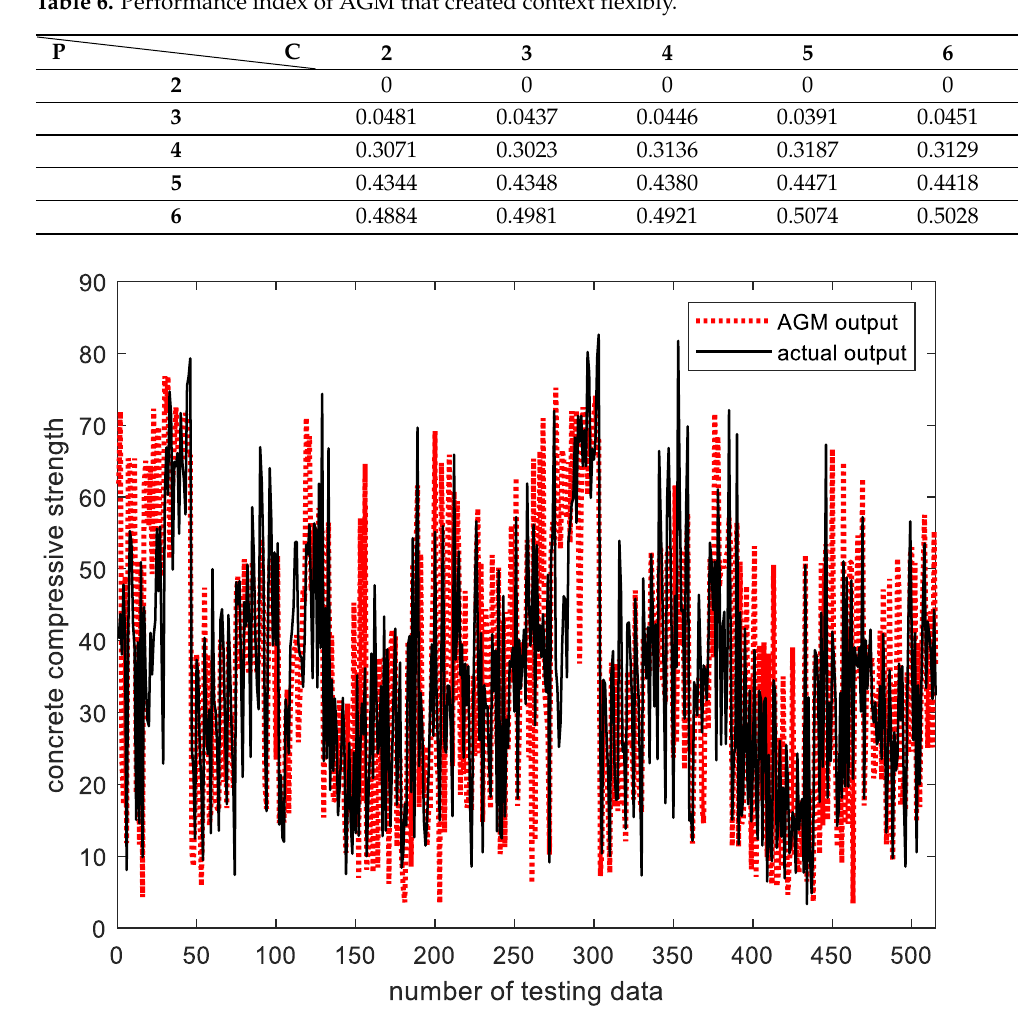
Figure 21. AGM’s performance index for validation data (context equally generated, number of con- texts = 6, number of clusters = 6). Table 7 shows the experimental results of concrete compressive strength prediction. As shown in the table, it can be seen that the existing GM creates the contexts equally and the performance index value for the verification data is 0.4276 when the context is 6 and